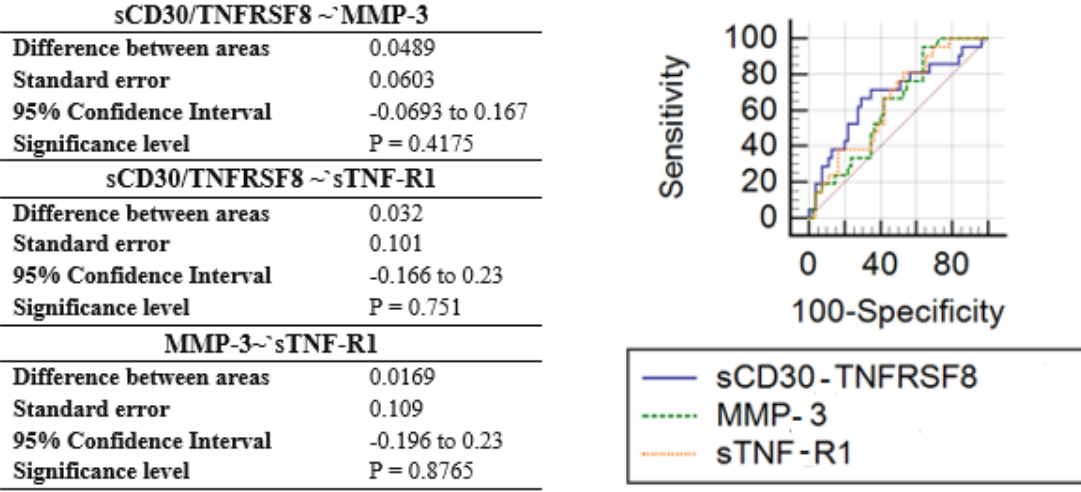
Figure 4. Pairwise comparison of ROC curves.